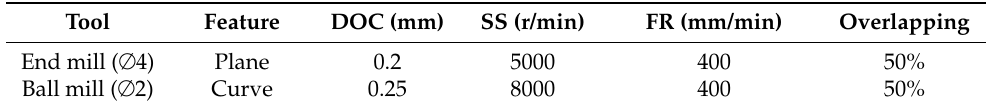
Table 4. Parameters for dry milling of the plane and curve